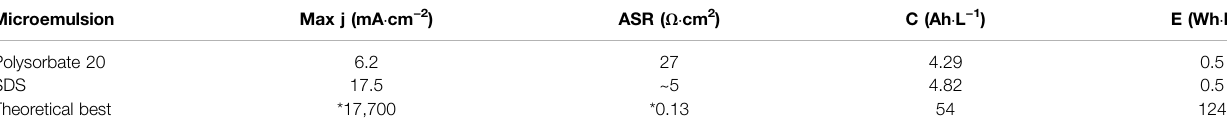
TABLE 2 | Microemulsion RFB — best performance comparison.